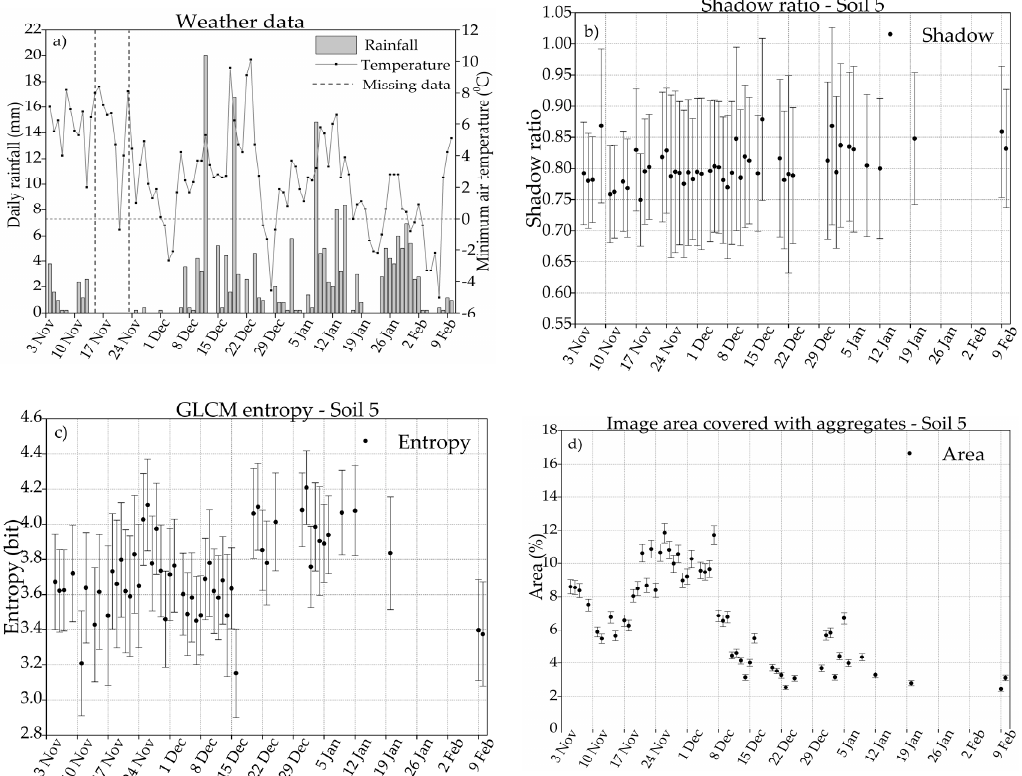
Figure 9. Weather data ( a ) together with shadow ratio ( b ), entropy ( c ); and area ( d ) results of Soil 5 are shown. Gray bars and gray line indicate daily rainfall and minimum air temperature, respectively. The gray dashed horizontal line indicates the temperature in ◦ C. The vertical black dashed lines show missing rainfall data interval from 15 to 23 November 2014. The error bars indicate the standard deviation of: shadow ratio ( b ); and entropy ( c ). The standard error bars of area ( d ) represent the 95% confidence interval of the true population mean for the sample size 54.